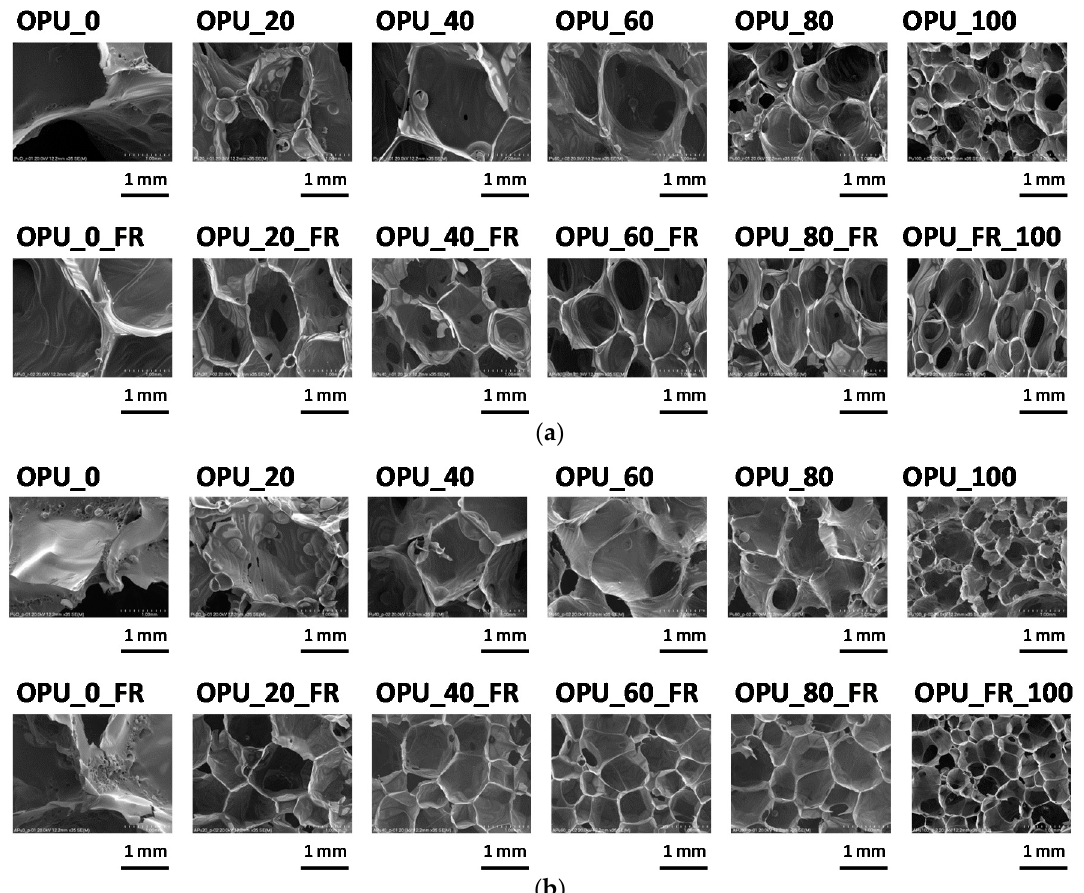
Figure 3. Cellular structure of foams modified with bio-polyol: ( a ) cross-section of the area parallel to foaming direction ( b ) cross-section of the area perpendicular to foaming direction.